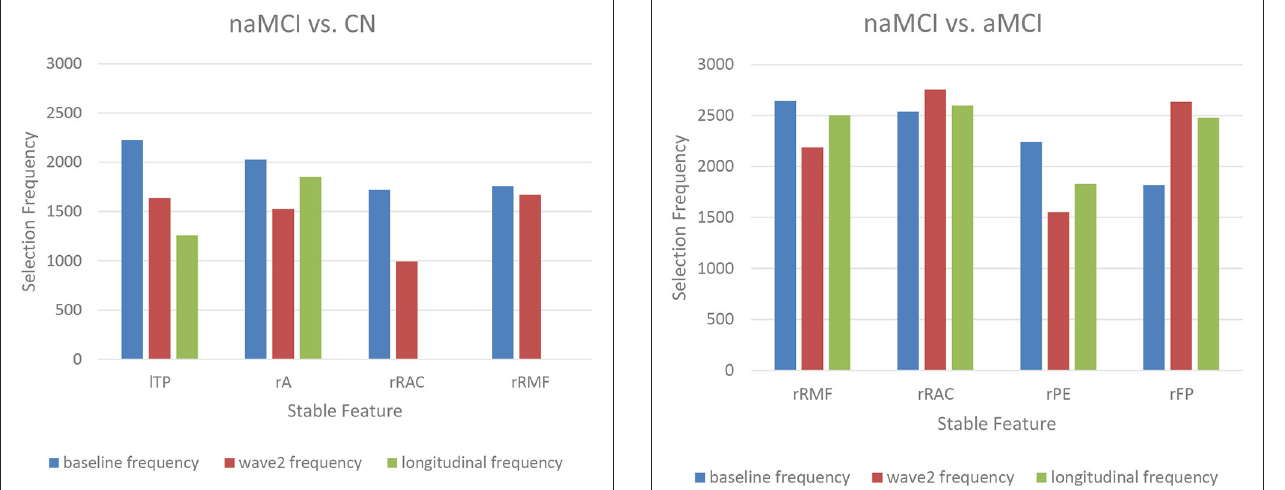
FIGURE 5 | The selection frequencies of the stable features for naMCI vs. aMCI classification. The baseline, wave-2 or longitudinal frequency are the selection frequencies of the feature measured at baseline, wave-2 or longitudinally, respectively. The selection frequency (between 0 and 3,000) of each feature is indicative of the discriminative power for classification. Volume of right rostral middle frontal and thickness of right pericalcarine are more discriminative in former time point, while volume of right frontal pole is more discriminative in later time point. And volume of right rostral anterior cingulate provide important information at all-time points. rRMF, right rostral middle frontal thickness; rRAC, right rostral anterior cingulate volume; rPE, right pericalcarine thickness; rFP, right frontal pole